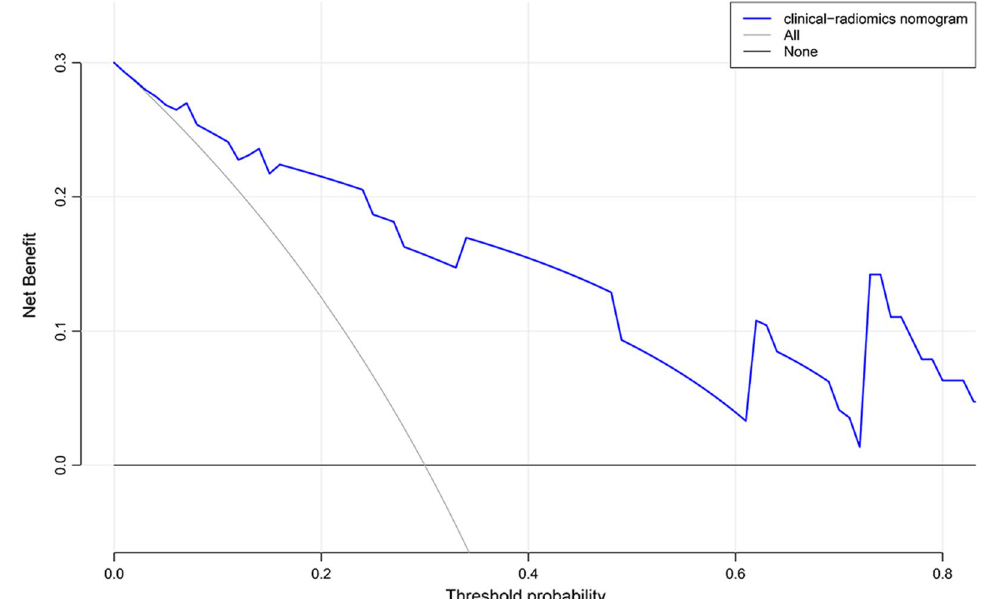
Fig. 6 DCA of the clinical–radiomics model in the testing group. The decision curve demonstrates that the clinical–radiomics model enables obtaining more net benefits for making clinical decisions if the threshold is greater than